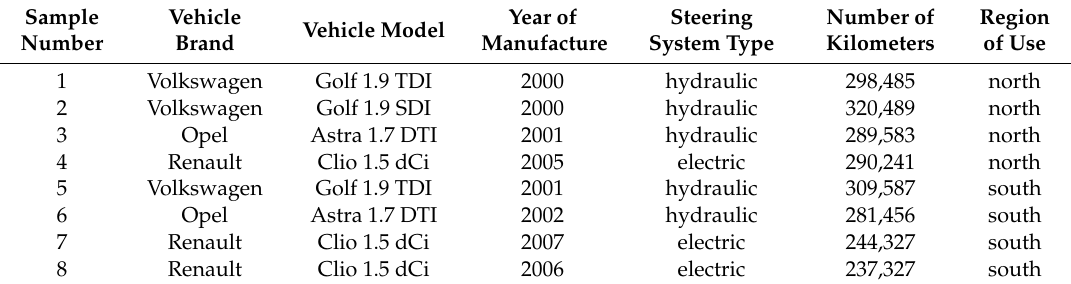
Table 1. The classification of vehicles for testing at temperatures from 4 ◦ C to 20 ◦